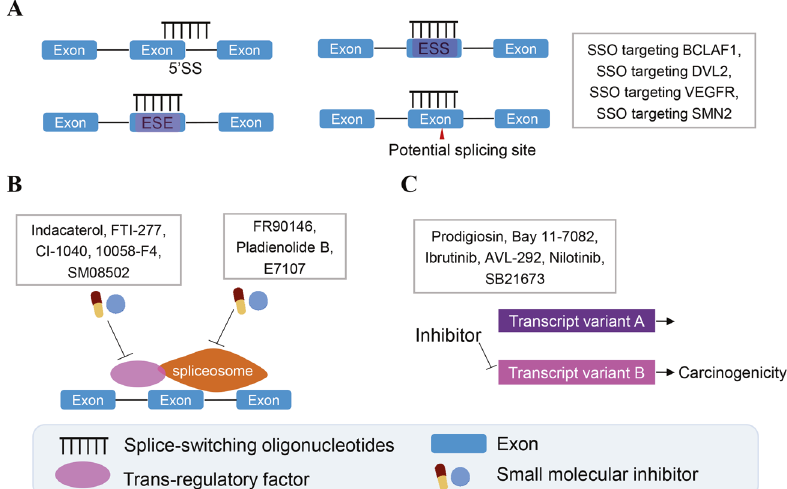
Fig. 4 The potential therapeutic strategies for treating patients with CRC by splicing alterations. Therapeutic strategies of splicing alterations include both the direct nucleic acid sites and splicing regulatory factor. A An ideogram shows splice-switching oligonucleotides (SSOs) targeting direct splicing site (5 ’ SS or 3 ’ SS), exon splicing enhancer (ESE) or inhibitor (ESI) and potential splicing sites. SSOs with experimental evidence were shown in the diagram. See text and Table 3 for detail. B Trans-regulatory factors are also targeted by small molecule inhibitors as treatment strategies through the splicing mechanism. Small molecule inhibitors targeting trans-regulatory factors and spliceosome are shown in the diagram. See text and Table 3 for detail. C Some special splicing variants related to carcinogenesis are effect targets for inhibitor and colorectal treatment. Inhibitors targeting oncogenic variants or signaling are shown in the diagram. See text and Table 3 for